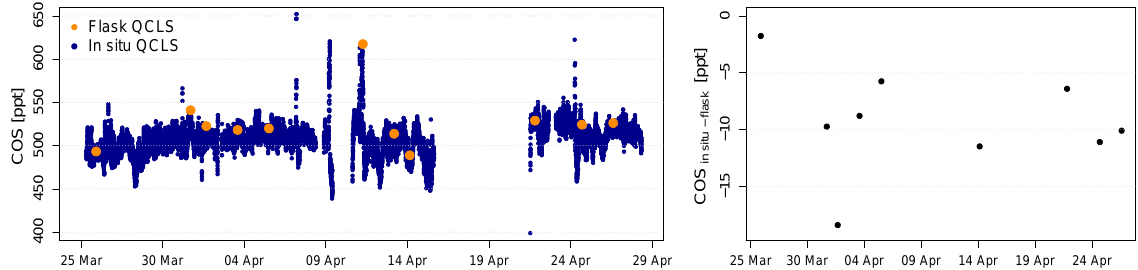
Figure 10. Minute-averaged measurements of COS at the Lutjewad measurement tower (60m) between 25 March and 29 April 2015 as measured in situ by the QCLS (blue), compared with dry air flasks samples measured at the QCLS (orange). The left plots show the time series; the right plots show the difference between the in situ and flask